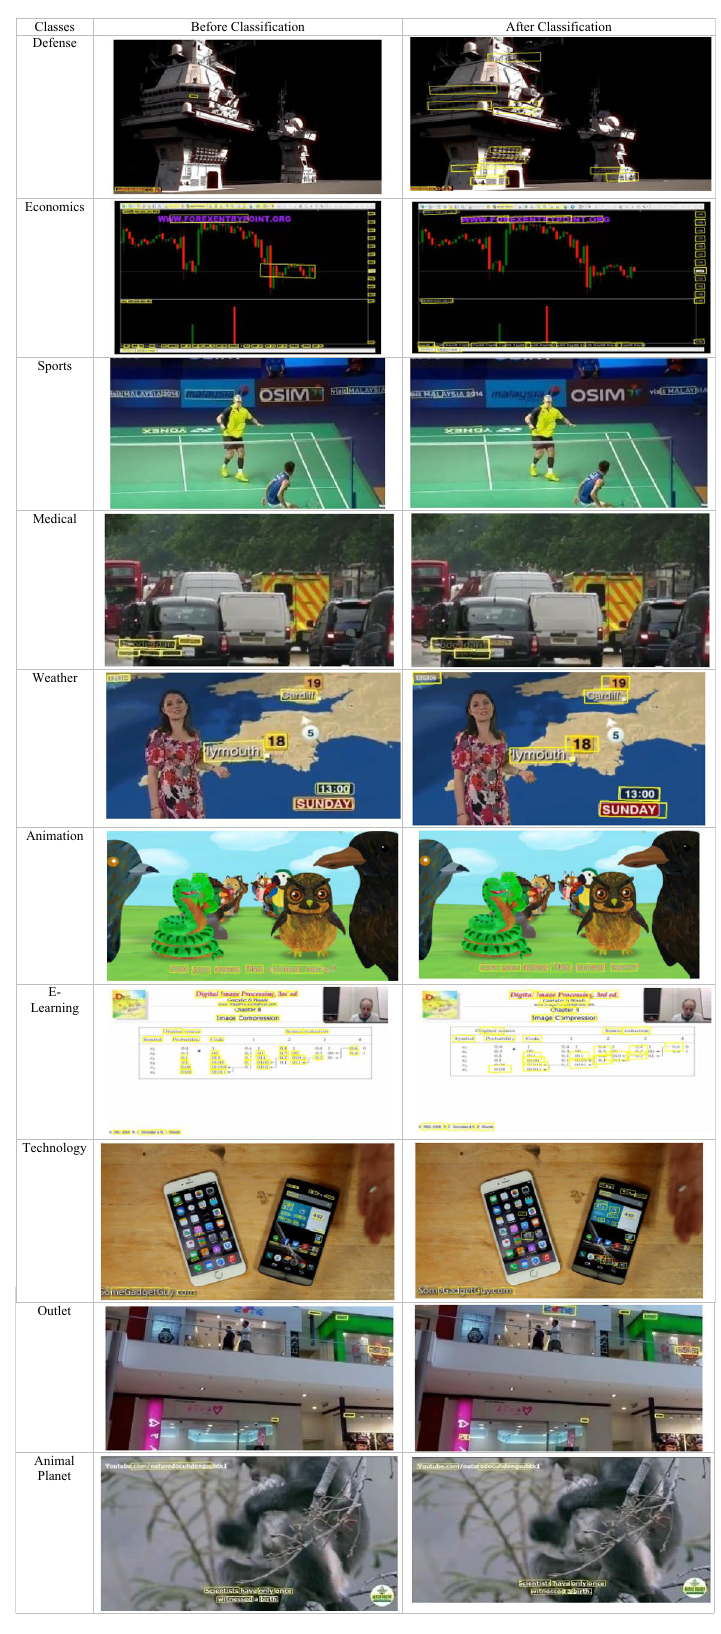
Fig. 10 Qualitative results of the text detection [9] on STD dataset before and after classi- fication. Original Source: [8,